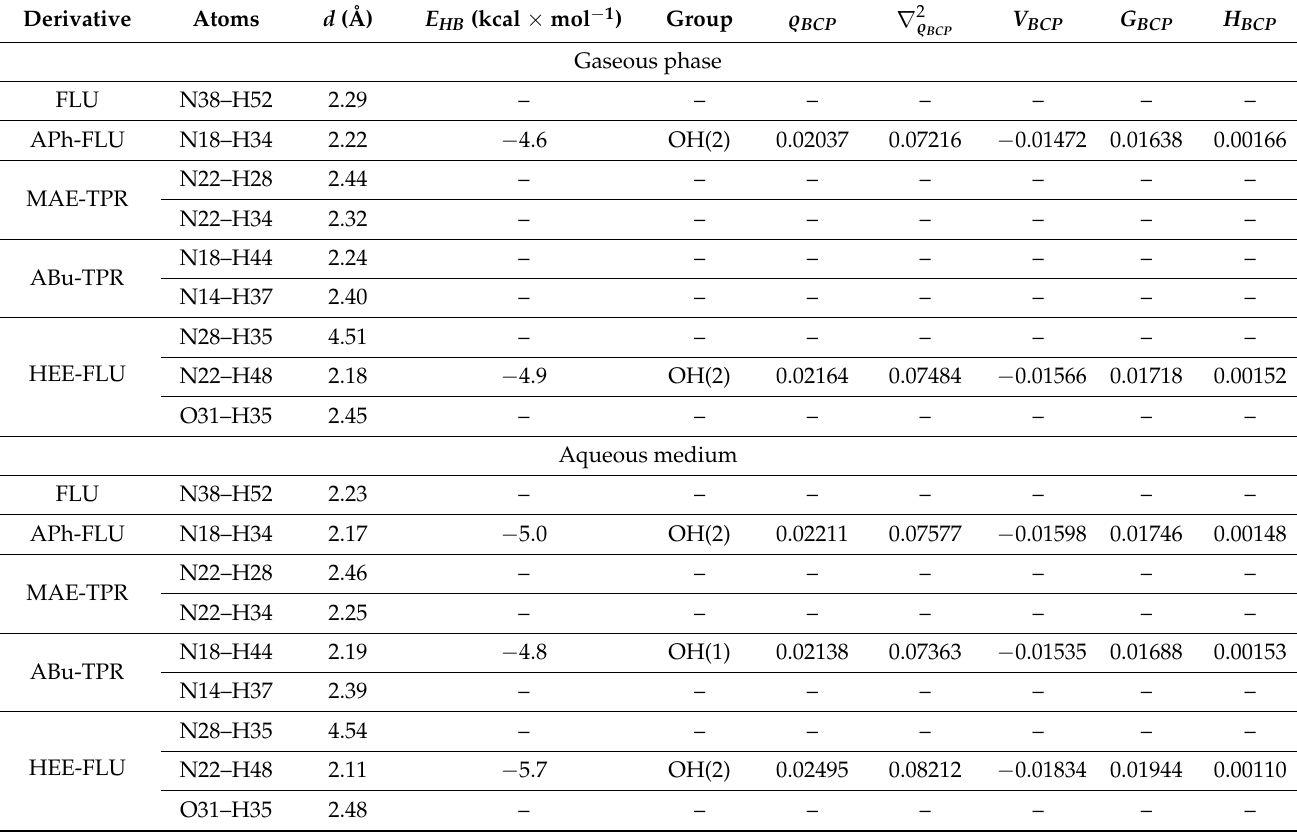
Table 3. Distance ( d ) between selected atoms in the gaseous phase and in the aqueous medium. Estimated value of H-bond energy ( E HB ). Calculated parameters (in atomic units) in gaseous and aqueous phases for the critical point of the bond path between the nitrogen atom of the side chain and the hydrogen atom of the given hydroxyl group: electron density ( (cid:36) BCP ), Laplacian of electron density ( ∇ 2 (cid:36) ), potential energy density ( V BCP ), kinetic electron density ( G BCP ), total energy BCP density ( H BCP